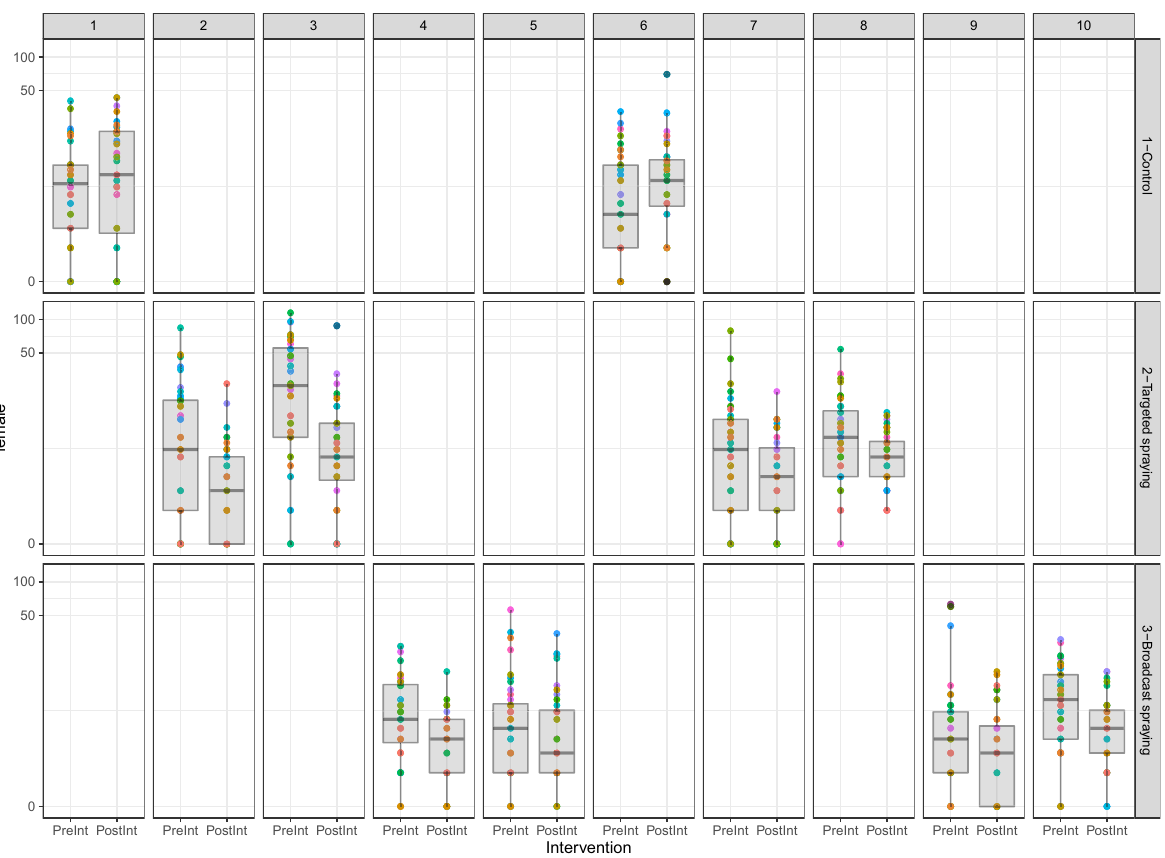
Figure 9. Plot the density of males and females, respectively. In these plots the columns refer to village ID and the rows to intervention type. Each cell shows the density colored by house (points) as well as a boxplot of the distribution of densities over households, both before and after intervention. The y-axis in each plot is given on a log-scale to make the differences in pre- and post-intervention densities more evident. The effect of pre-intervention density had a highly significant negative effect (p-values < 0.001). For the modeled change in female density, coefficients for targeted spraying and broadcast spraying were significant at 0.05 threshold (p-values = 0.003 and p-values = 0.001, respectively).